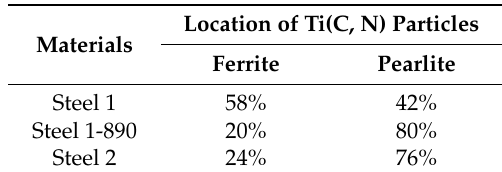
Table 4. Location of Ti(C, N) particles in samples.